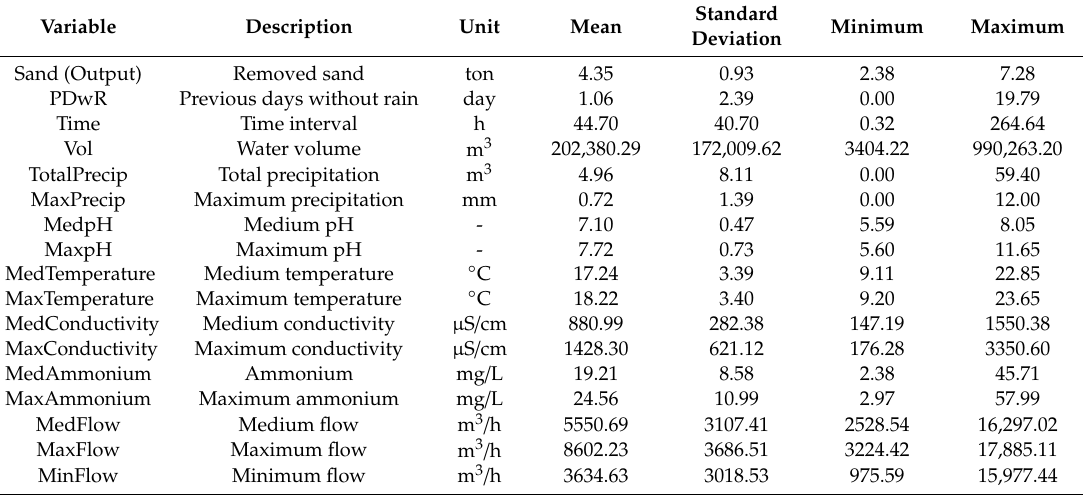
Table 2. Statistical description of the